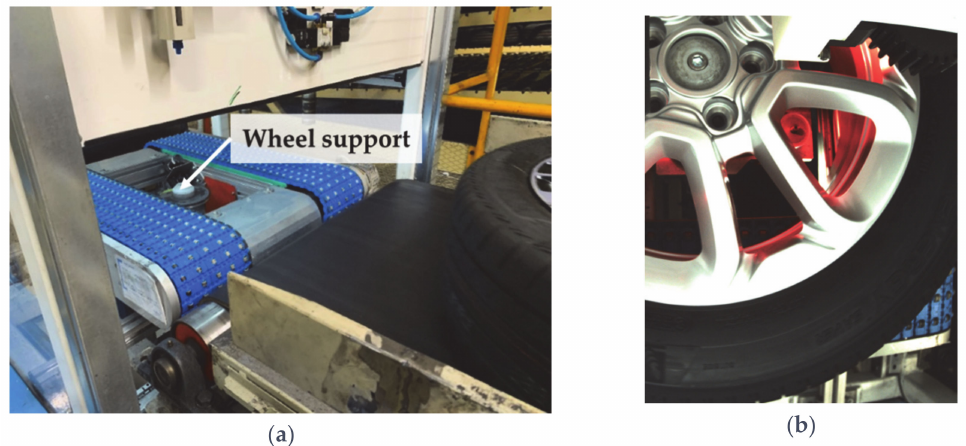
Figure 2. Pictures showing ( a ) the apparatus used for quality control of the tire-wheel assembly and ( b ) the measuring phase seen from the top of the control